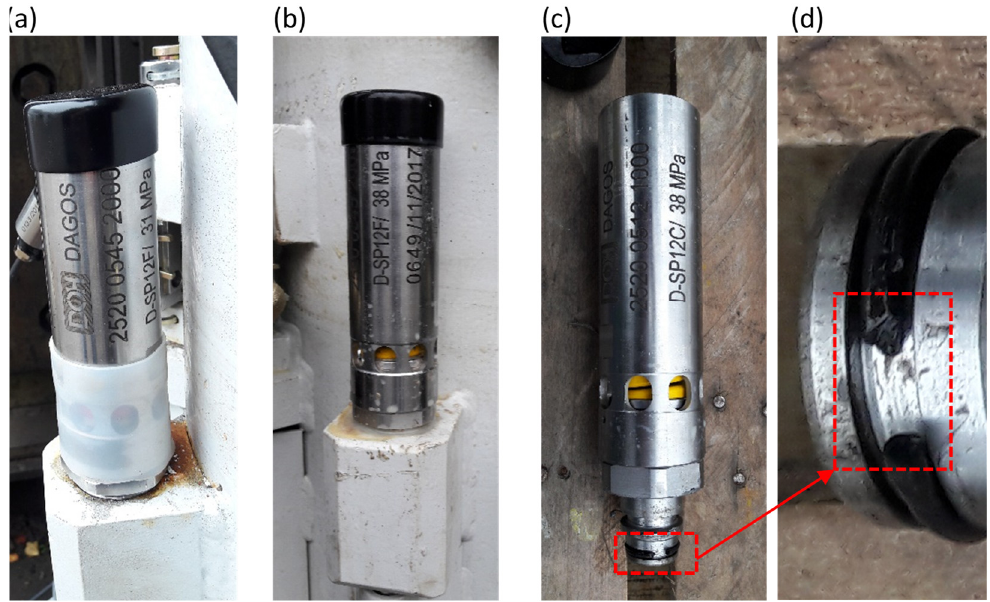
Figure 4. View of tested valve, where: ( a ) valve before test, ( b ) valve after test, ( c , d ) damaged gasket after test.